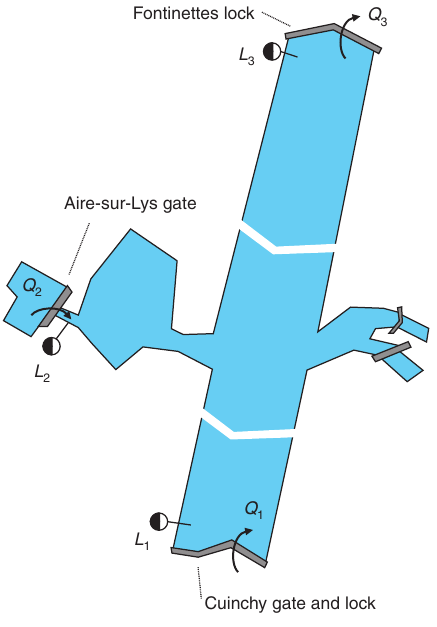
Figure 5. Scheme of the Cuinchy–Fontinettes Navigation